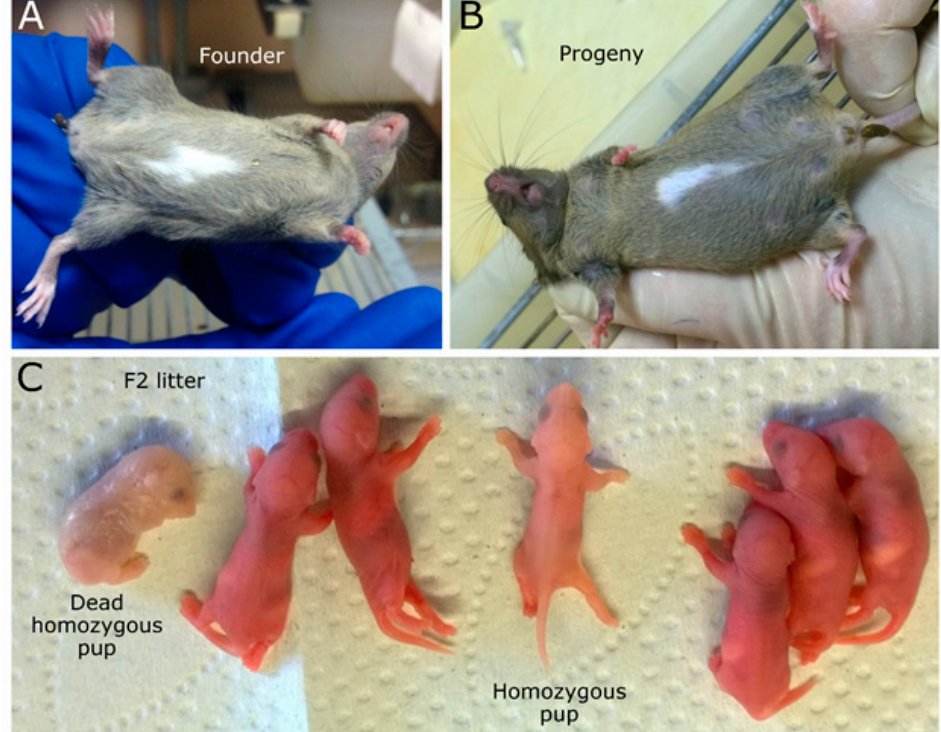
Figure 2. Phenotypic consequence of an on-target deletion. ( A ) Founder with a white spot on the belly. ( B ) F1 progeny with white-spotting phenotype. ( C ) Offspring from the crossing between two heterozygotes with a white spot. Int. J. Mol. Sci. 2020 , 21 , 3604